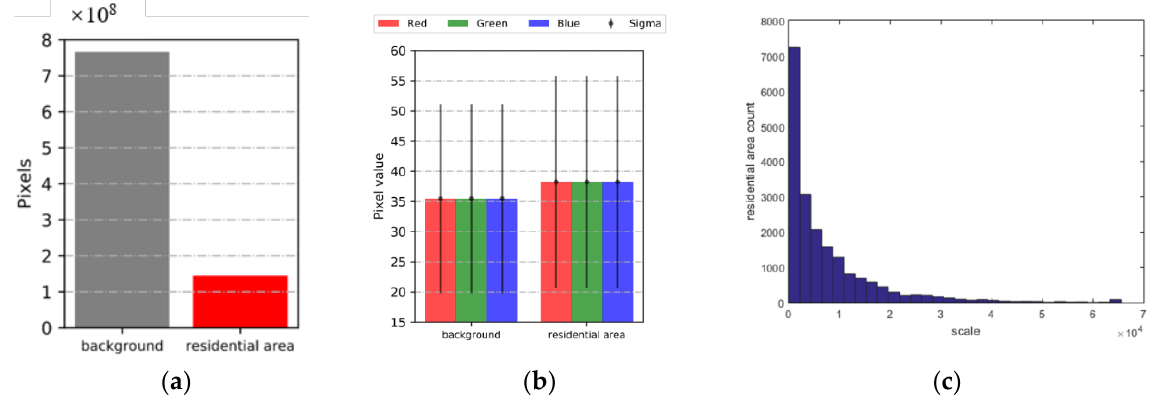
Figure 5. Statistics for the RERB dataset: ( a ) Histogram of the number of pixels for each class; ( b ) spectral statistics. The mean and standard deviation (sigma) for background and residential area are reported; and ( c ) distribution of the residential area sizes.